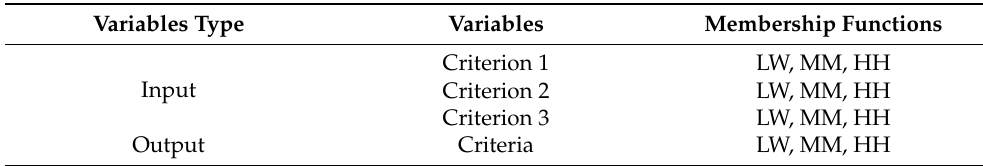
Table 9. Type-2 fuzzy